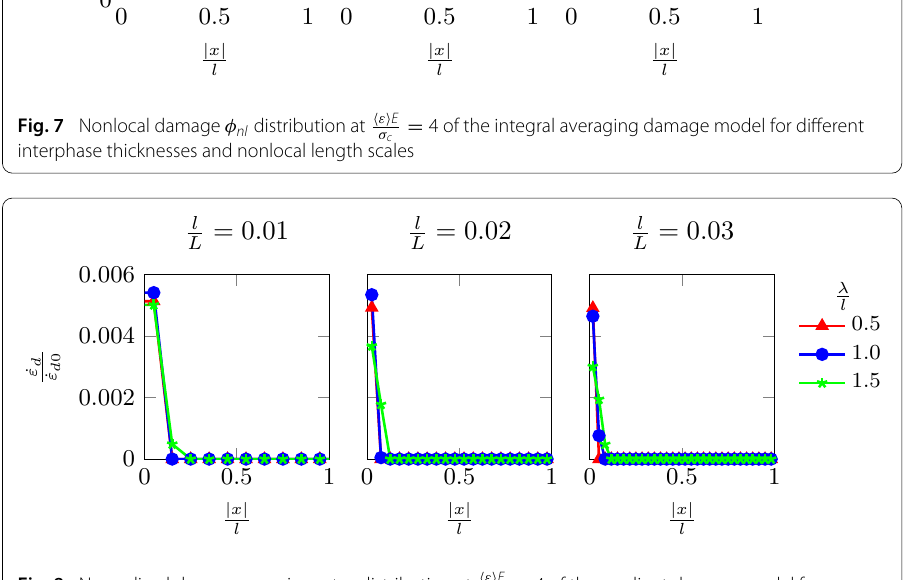
Fig. 8 Normalised damage opening rates distribution at (cid:3) ε (cid:4) E σ different interphase thicknesses and nonlocal length scales